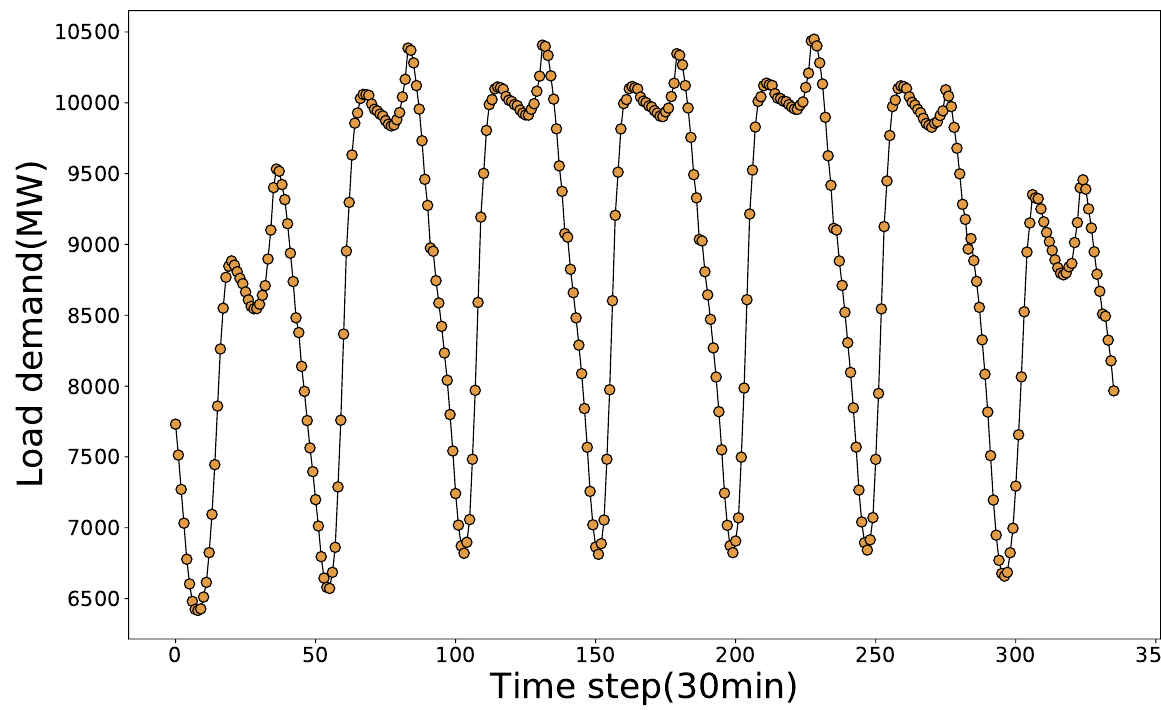
Figure 1. Load demand variation in one